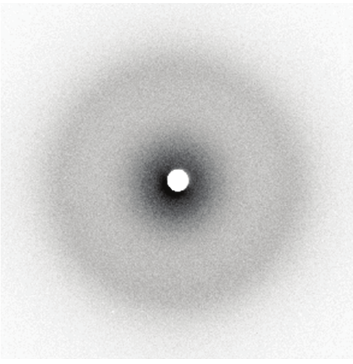
Figure 3: X-ray di ff raction pattern of POC(12,6).